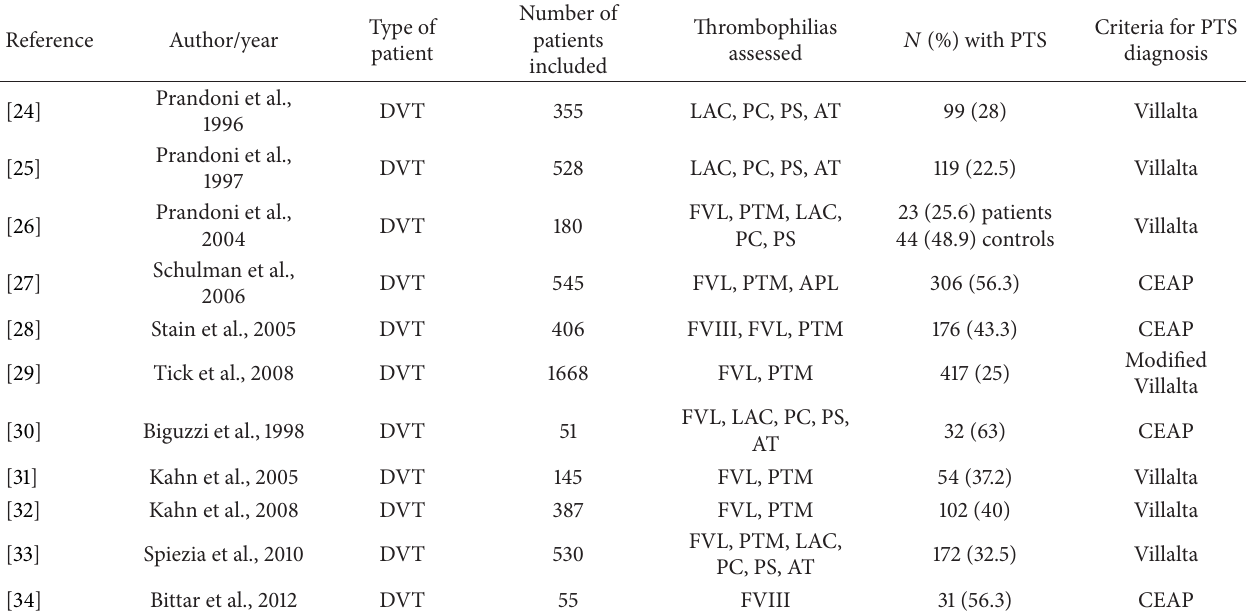
Table 1: Included studies in deep vein thrombosis